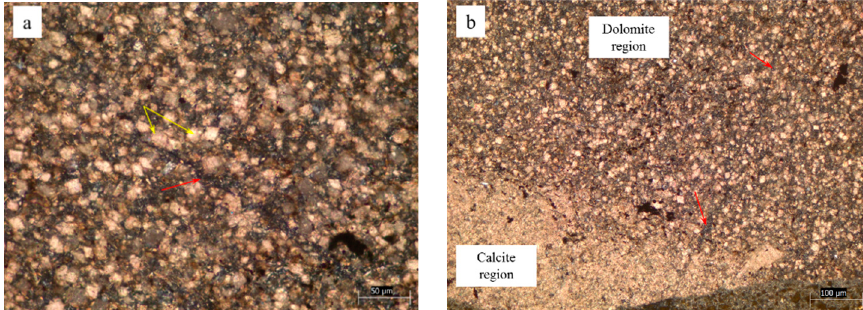
Figure 5. Expansion cracks in concrete microbar of YMS1 cured in TMAH solution for 56 days: ( a ) crack in dolomite region; ( b ) crack in calcite region.